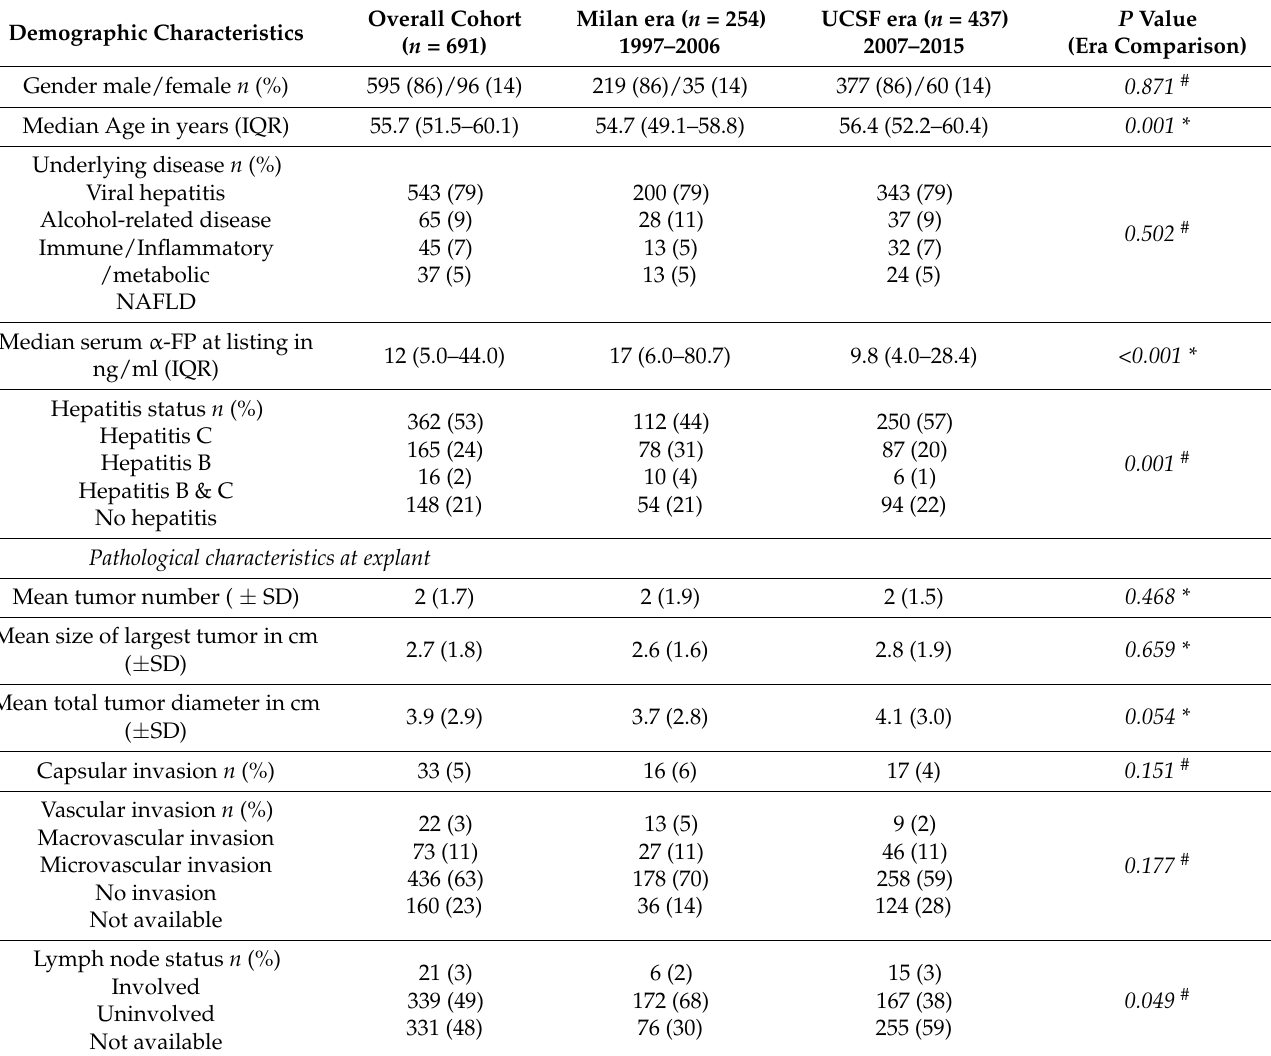
Table 1. Patient characteristics (Abbreviation: IQR = interquartile range; SD = standard